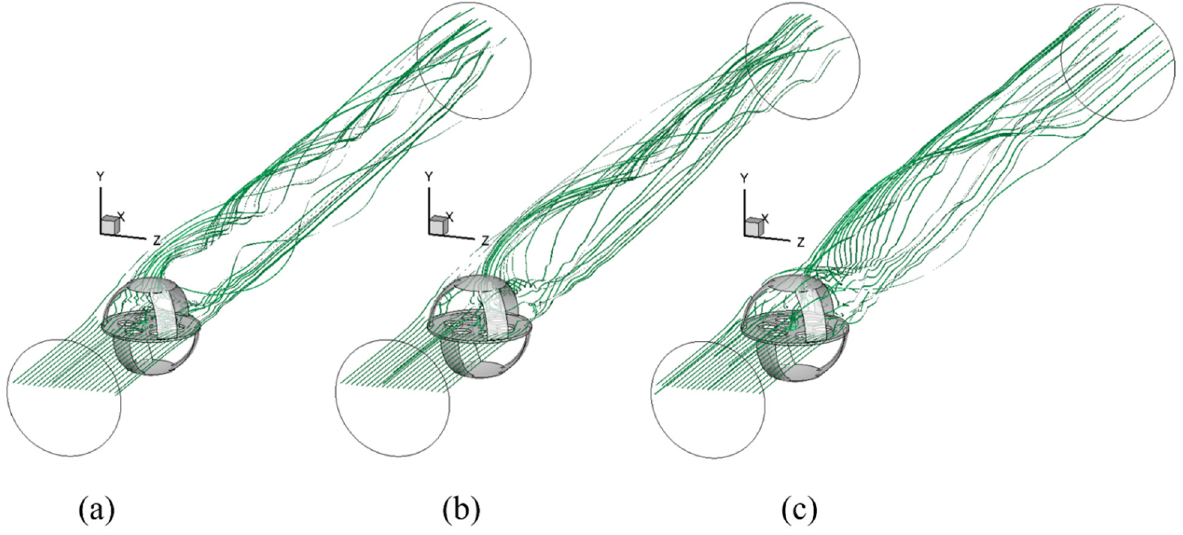
Figure 18. Wake flow streamlines configuration with tip clearance: ( a ) 19.3%, ( b ) 15.0% and ( c ) 12.0%, respectively.